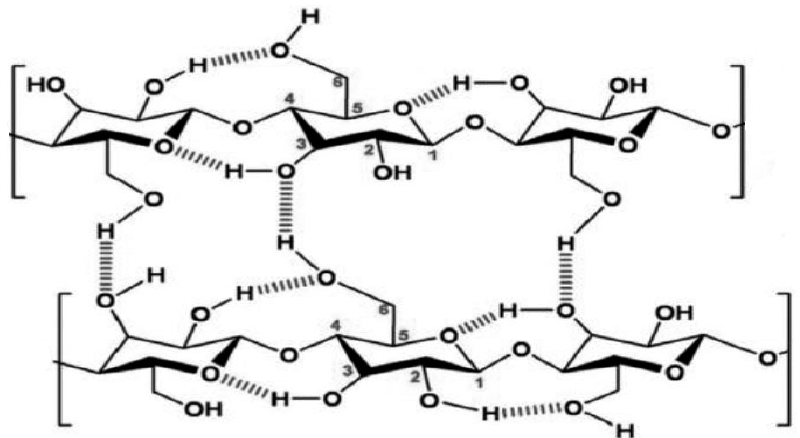
Figure 1. Structural formula of cellulose.